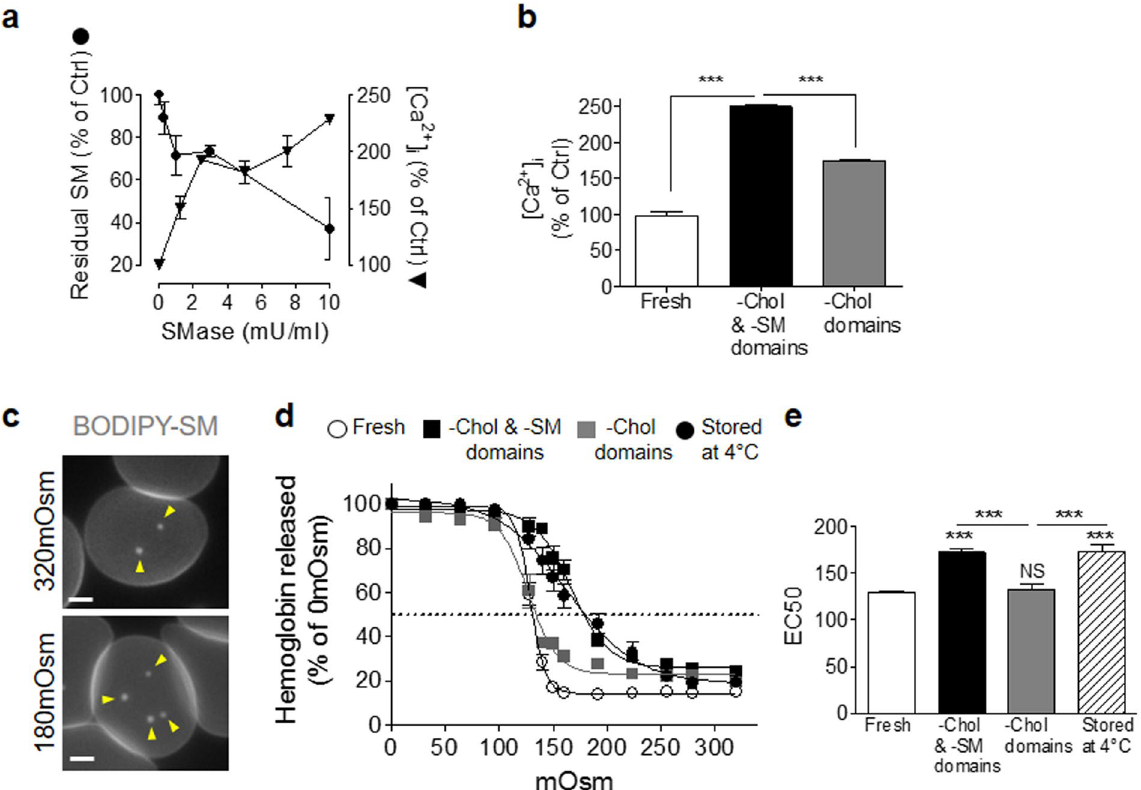
Figure 8. Impairment of intracellular calcium concentration and volume increase ability upon SM-enriched domain abrogation. ( a ) Fresh healthy RBCs were preincubated with Fluo-4, treated with the indicated concentrations of sphingomyelinase (SMase) to deplete endogenous SM and evaluated for SM residual content ( black circles ) and [Ca 2 + ] i ( black triangles ). Results are expressed as percentage of control (0 mU/ml SMase) and are means ± SEM from three independent experiments. ( b ) RBCs were preincubated with Fluo-4, treated to abrogate both chol and SM domains ( -Chol & -SM domains ) or chol domains only ( -Chol domains ) as described in Fig. 5 and then evaluated for [Ca 2 + ] i . Results are expressed as percentage of untreated RBCs and are means ± SEM of 8 samples from two independent experiments. ( c ) RBCs were labelled with BODIPY-SM, washed, spread onto PLL-coated coverslips and visualized by fluorescence microscopy in media of indicated osmolarity. Representative imaging of 4 independent experiments, scale bars 2 µ m. Yellow arrowheads point to the central area of the RBC membrane. ( d,e ) Fresh RBCs treated for domain abrogation (as in Fig. 5c) or stored at 4 °C were incubated in media of indicated osmolarity and evaluated for haemoglobin release (d, average haemoglobin absorbance by sample expressed as a percentage of 0 mOsm; e, EC50). Results are means ±